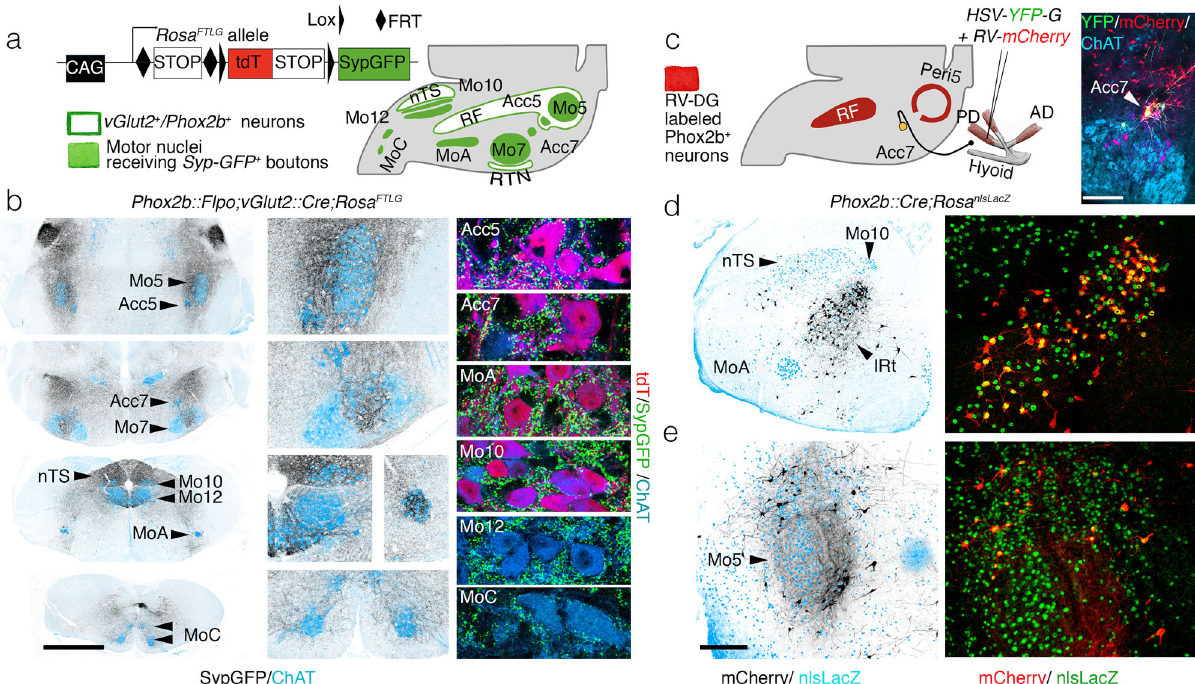
Fig. 1 Premotor status of reticular formation Phox2b + interneurons. a Rosa FTLG allele used for intersectional transgenic labeling of boutons from vGlut2/ Phox2b interneurons (left) and schematic of the results (right). b Coronal sections through the hindbrain of a Phox2b::Flpo ; vGlut2::Cre ; Rosa FTLG mouse at P4, showing synaptic boutons (black) from vGlut2/Phox2b interneurons in relation to motor nuclei (ChAT + , blue) at low (left), and higher (middle) magni fi cations, and close-ups of boutons (green) on motoneurons (right), which are either Phox2b + (purple) or Phox2b − (blue). c (left) Strategy for mono- synaptically restricted transsynaptic labeling of premotor neurons from the posterior digastric muscle (PD) in a Phox2b::Cre ; Rosa nlsLacZ mouse, with G-deleted rabies virus (RV) encoding mCherry and complemented by a G-encoding helper HSV virus ( HSV-YFP - G ), and summary of the results. (right panel) The only seed neurons are Acc7 motoneurons, double-labeled by the HSV-G and RV-mCherry viruses. d , e Coronal sections through the hindbrain at P8 showing labeled premotor neurons (black on the left panels) in the IRt ( d ) and Peri5 ( e ), which for the most part (72.7% ± 3.5 SEM, n = 4 animals) express Phox2b (right panels). AD anterior digastric, IRt intermediate reticular formation, nTS nucleus of the solitary tract, PD posterior digastric, Peri5 peritrigeminal area, RF reticular formation, RTN retrotrapezoid nucleus. Scale bars, b 1 mm for the left column, c 250 μ m, d , e 500 μ